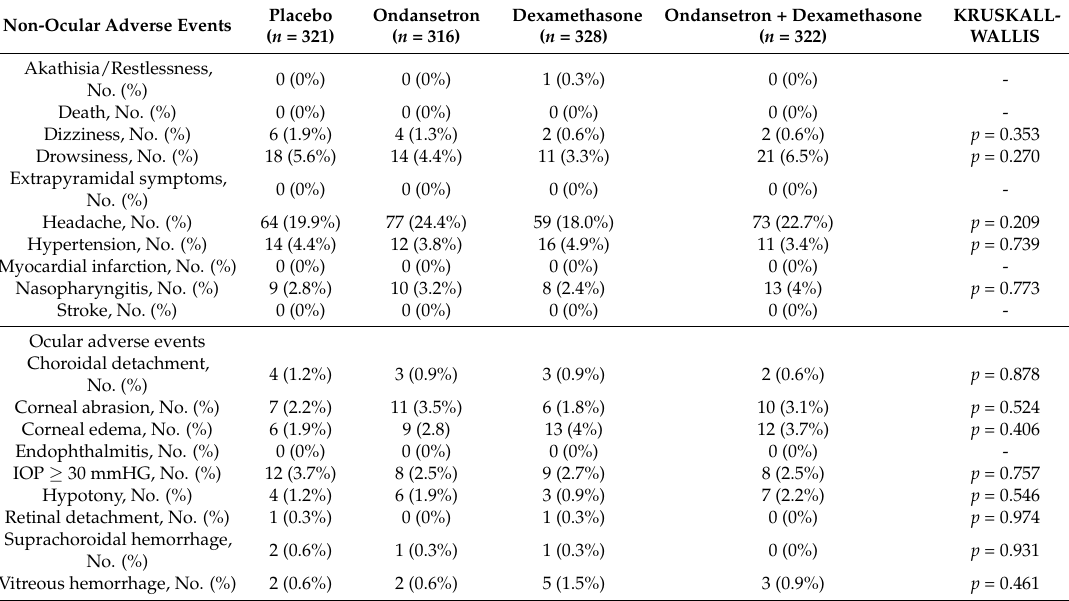
Table 6. Rate of adverse